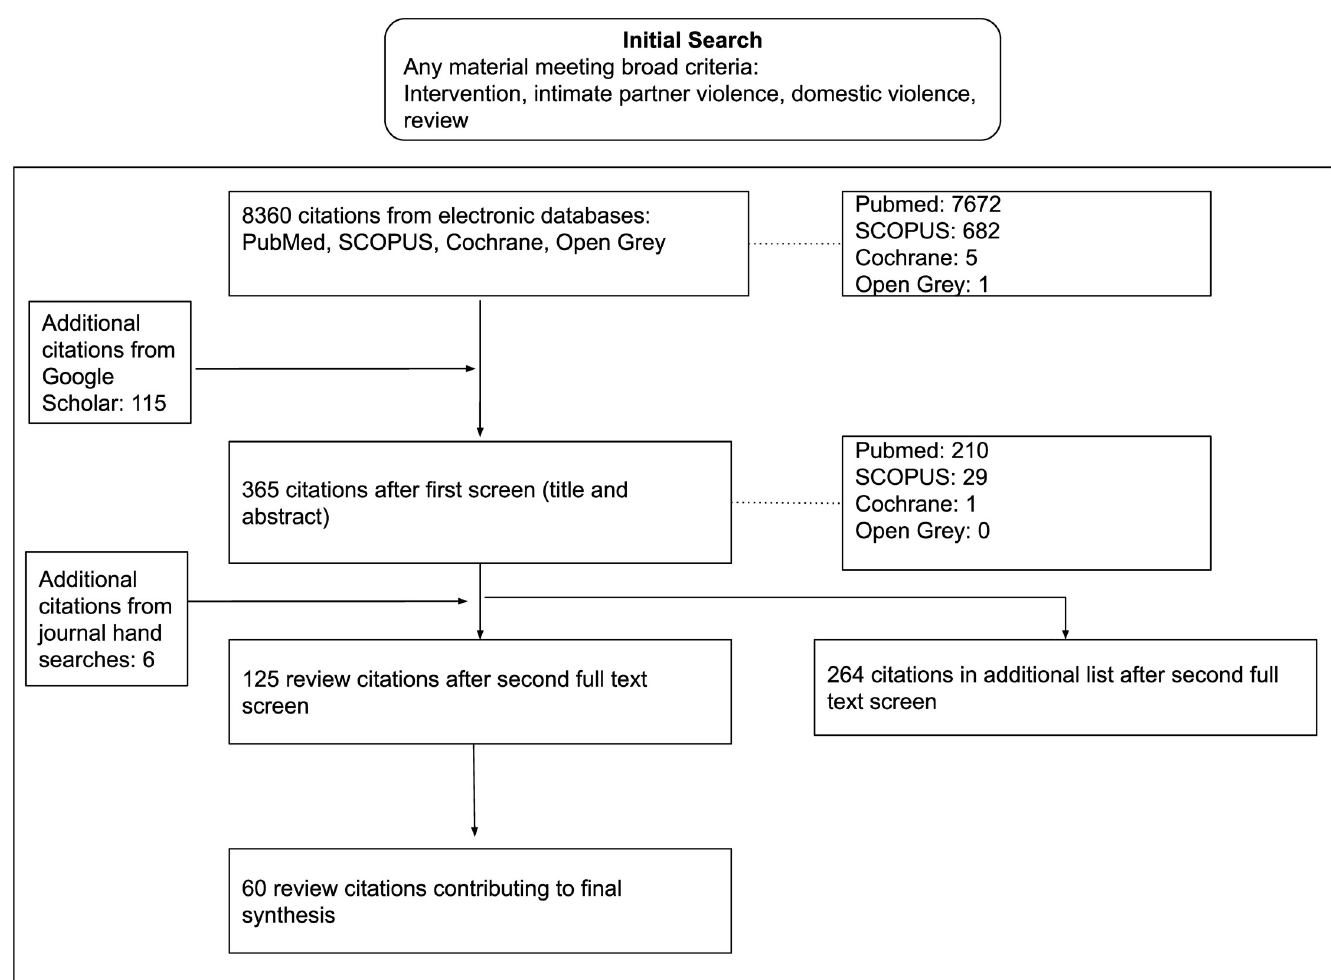
Fig 1. Flow diagram illustrating the search process and article